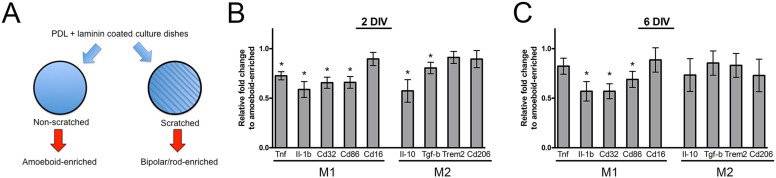
Reduced expression of M1 and M2 markers in bipolar/rod-shaped microglia.(a) Schematic diagram illustrating the amoeboid-enriched and bipolar/rod-shaped enriched cultures. (b) Reduced expression of selected M1 and M2 markers in the bipolar/rod-enriched microglia cultures compared with the amoeboid-enriched cultures at 2 DIV (n = 5 to 6). (c) This reduced M1 marker expression was generally maintained, whereas M2 marker expression increased at 6 DIV (n = 5 to 6). *P < 0.05 based on Student's t-test.